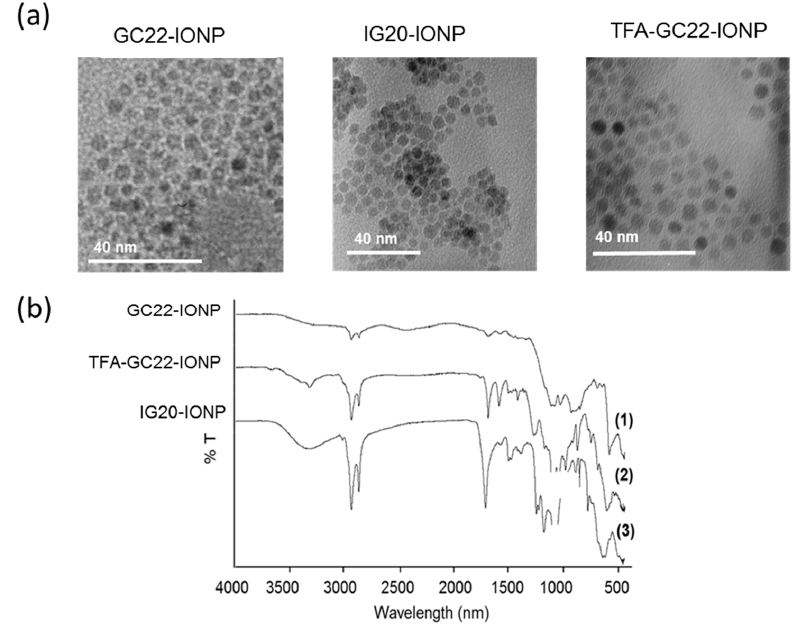
Figure 3. Characterization of the glycosides-coated IONP. ( a ) TEM images and ( b ) FTIR spectra of the three glycoside-coated IONP. three glycoside-coated